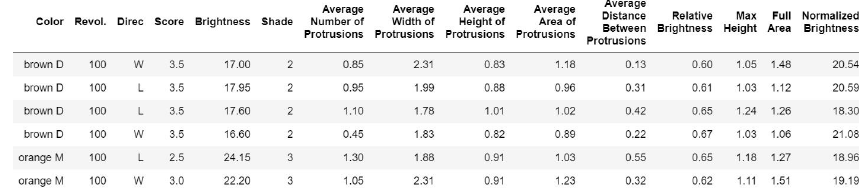
Figure 6. Distribution of the binary target class. 4.2. Dataset Processing and Preparation 4.2.1. Missing Values and Outliers Detection The treatment of missing values is an important step in training machine learning models. Missing values result from various reasons such as incomplete forms, unavailable values, etc. Multiple methods have been suggested to compute missing values [32]. They can be calculated using business logic or even deleted when their percentage is very high. The classical methods are to use mean, median, and mode. Mean is used for numerical variables when there are not many outliers in the dataset; median is used for numerical variables when there are outliers in the dataset; mode is used to treat categorical variables. In this research, we dropped some rows and columns with missing meaningless features such as: code/ID of the fabric, the date the image was taken, etc. The presence of outliers in a classification or regression dataset can result in a poor fit and lower predictive modeling performance. Automatic outlier detection methods can be used in the modeling pipeline and compared. Figure 7 presents the box plot graphs for some of the important features in the dataset.